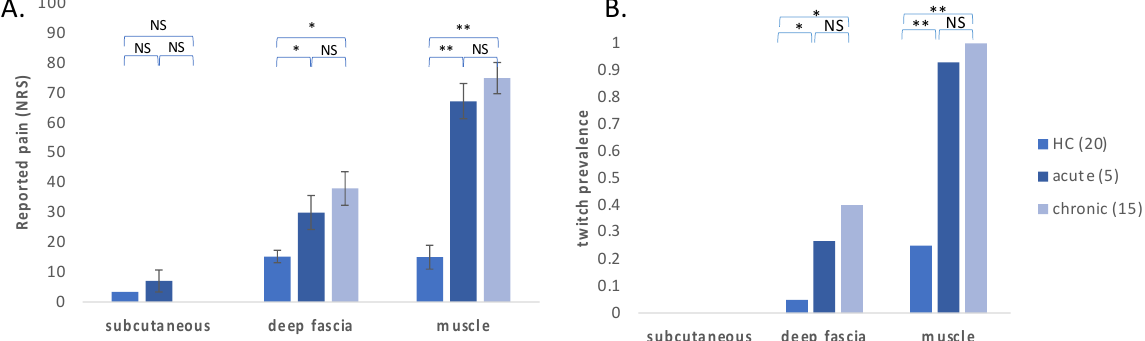
Figure 2. Evoked pain intensity and twitch response among LBP patients and healthy controls. ( A ) Patient-reported evoked pain in muscle, fascia and skin among LBP patients and healthy controls; ( B ) incidence of twitch response when stimulating the muscle, fascia and skin of LBP patients and healthy controls. (* p < 0.05 and ** p < 0.0001; NRS—numeric rating scale, NS—not significant).